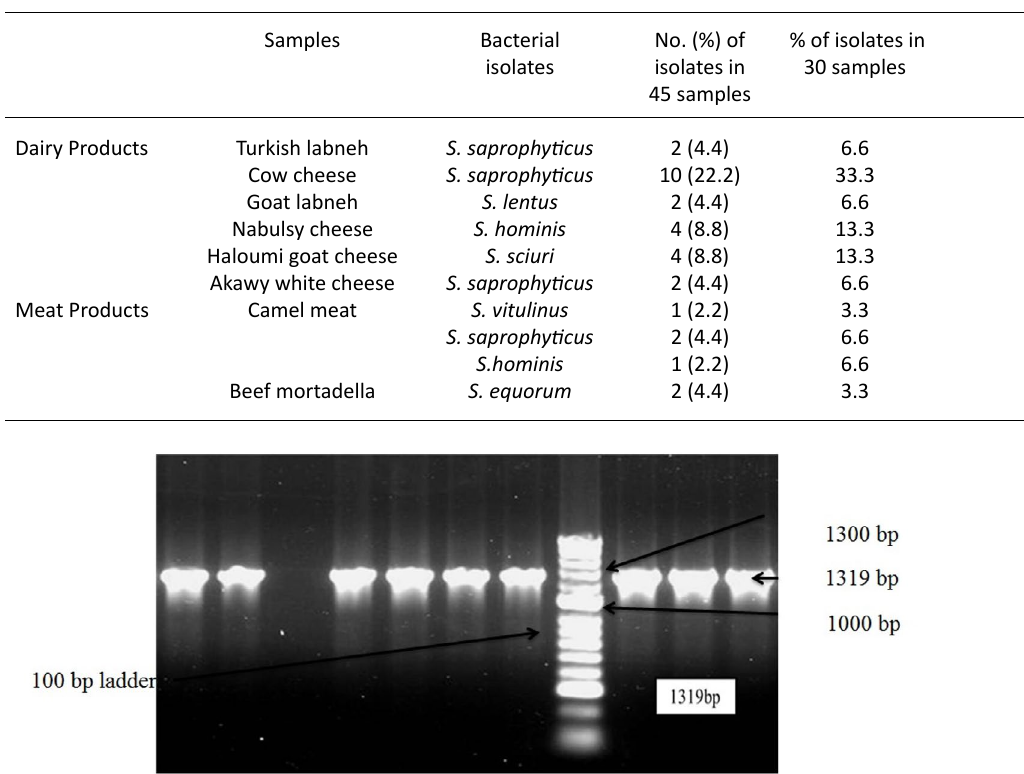
Table 4. Distribution of CoNS isolates in food products and in which sample isolated